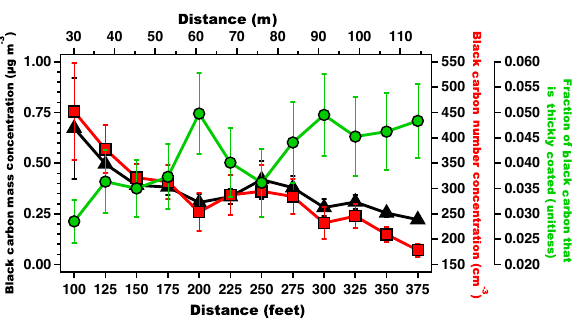
Figure 1. Black carbon mass concentration (µgm − 3 ), black carbon number concentration (cm − 3 ), and fraction of black carbon that is thickly coated ( f ) vs. downwind distance from Interstate 405 in Los Angeles, California. Error bars represent 95% confidence intervals computed using 10s